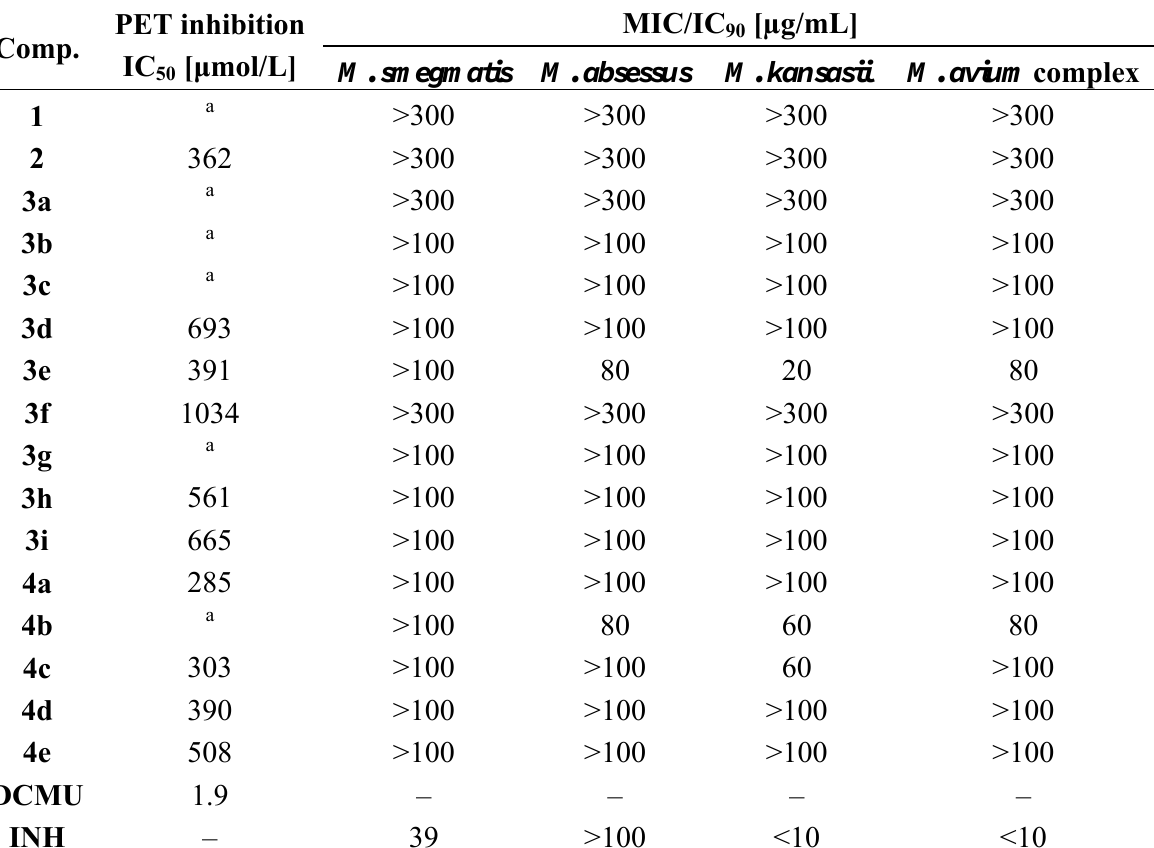
Table 2. IC values related to PET inhibition in spinach chloroplasts in comparison with 50 3-(3,4-dichlorophenyl)-1,1-dimethylurea (DCMU) standard and in vitro antimycobacterial of compounds 1 - 3i , 4a - 4e in comparison with the standard, isoniazid activity MIC/IC 90